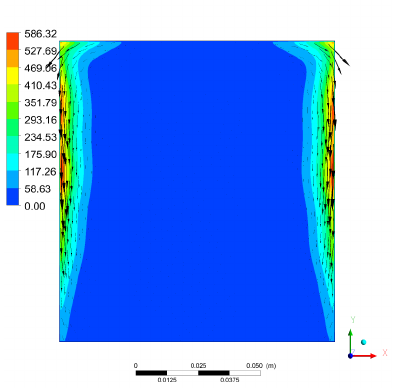
Figure 5. Cut surface of liquid metal volume with Lorentz forces [N/m 3 ].